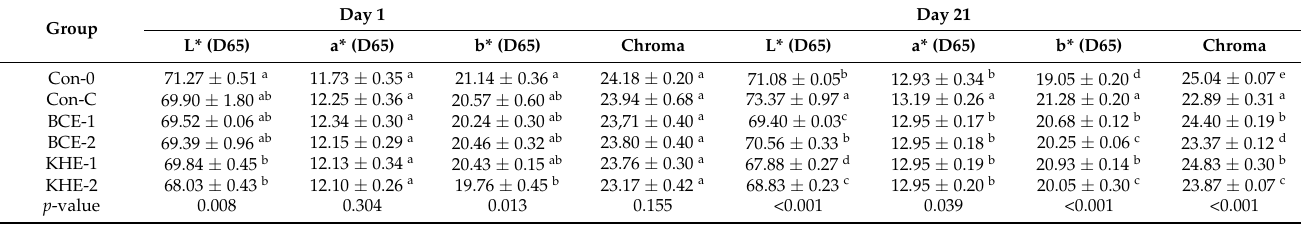
Table 4. Results of color measurement expressed in coordinates in color